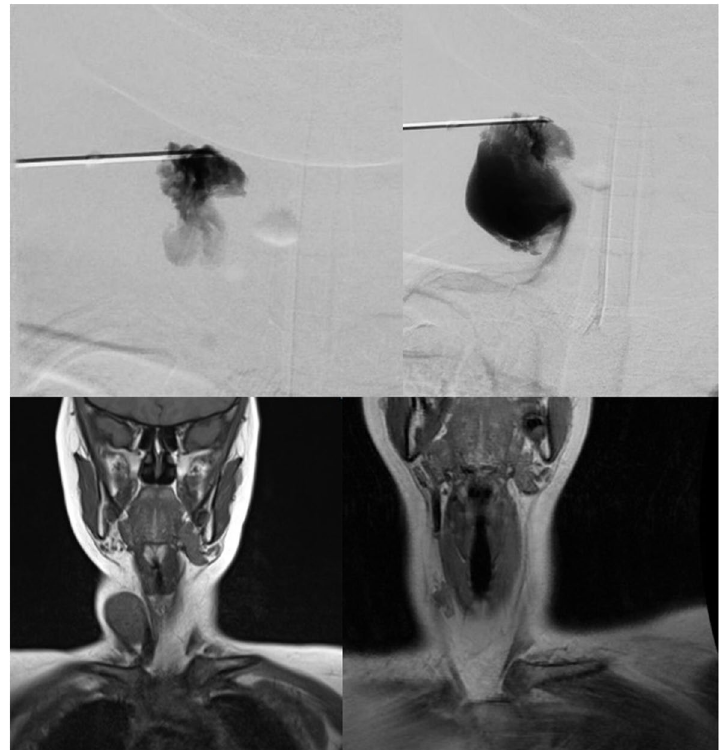
Fig. 7 Patient with a VM in the neck area. Above: Phlebographic findings before the intervention. Bottom: MRI findings before the intervention (left) and after